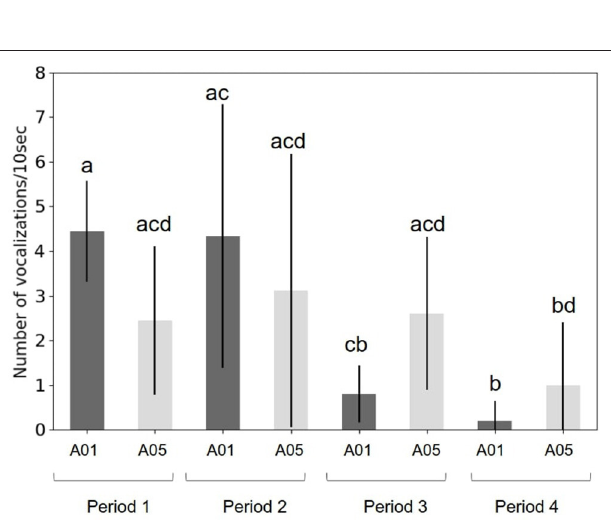
FIGURE 10 | Graph of the call rate of the 30th of August for each period and for the A01s (dark gray) and the A05s (light gray).